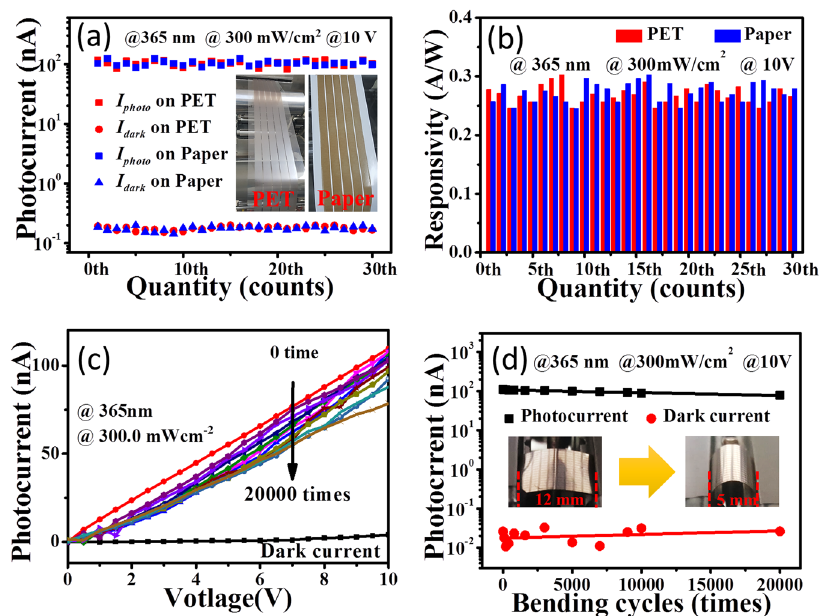
Fig. 5 a Distribution diagram of photocurrent and dark current of PBDTT- ff Qx/PCBM BHJ photodetectors in a large-scale thin fi lm on fl exible PET and paper substrates. The insets are the photos of BHJ thin fi lms on PET and paper substrates, respectively. ( b ) Statistical chart of R values of photodetector array on PET and paper substrates. ( c ) I – V curves of PBDTT- ff Qx/PCBM BHJ photodetector measuring under 365 nm illumination for bending from 0 to 20,000 cycles. d The change trends of photocurrent and dark current of the PBDTT- ff Qx/PCBM BHJ photodetector with 20,000 bending cycles. The inset shows the bending process of PBDTT- ff Qx/PCBM BHJ photodetector from the original state